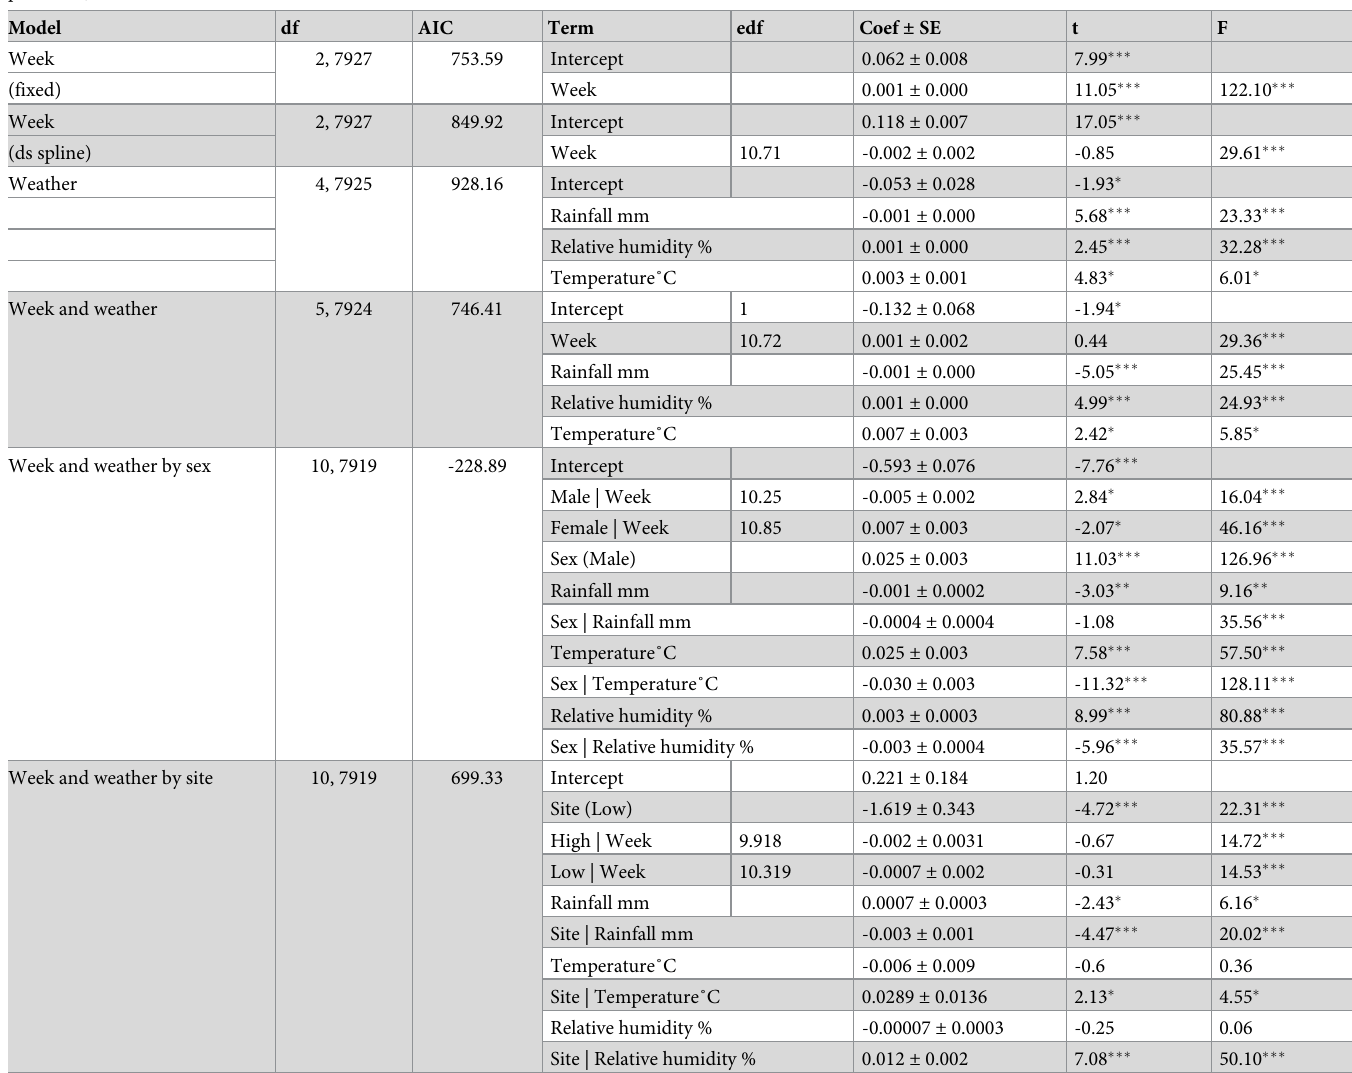
Table 2. Analysis of variance and estimated regression coefficients taken from generalized additive mixed models for average daily catch rates of P . downsi , with fixed effects of fly sex and site and comparing models where time (study week) is treated as a fixed factor or fitted using a smoothing spline (edf = estimated degrees of freedom for the spline). Also compared are models where interactions between weeks and site/sex and weather and site/sex are fitted ( � p < 0.05, �� p < 0.01, ��� p <